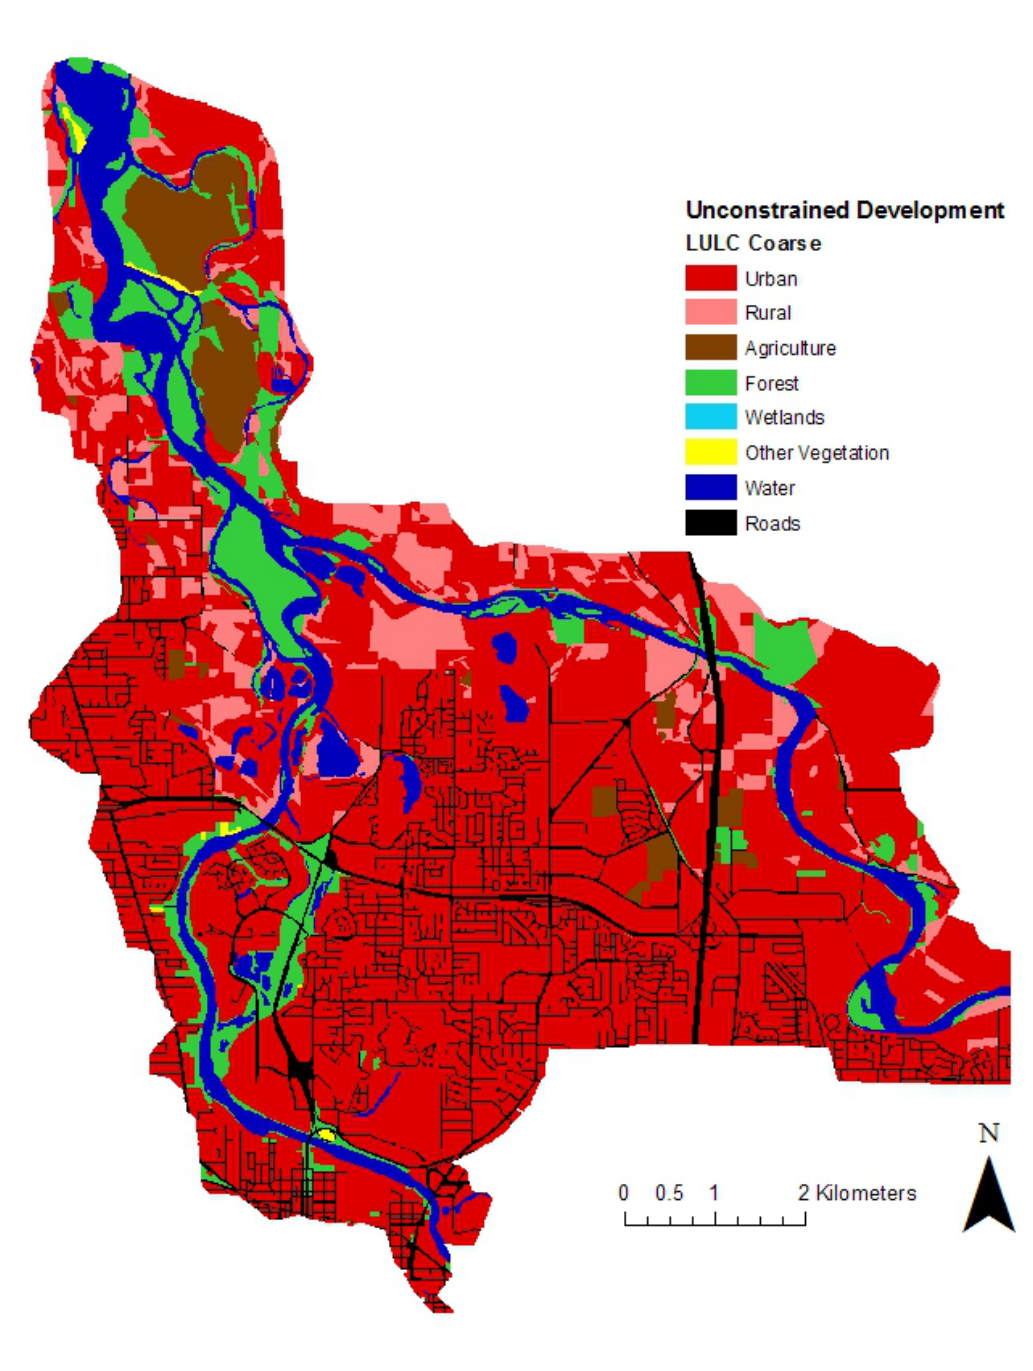
Fig. 11 . Study area after a typical 50-yr run of the unconstrained development